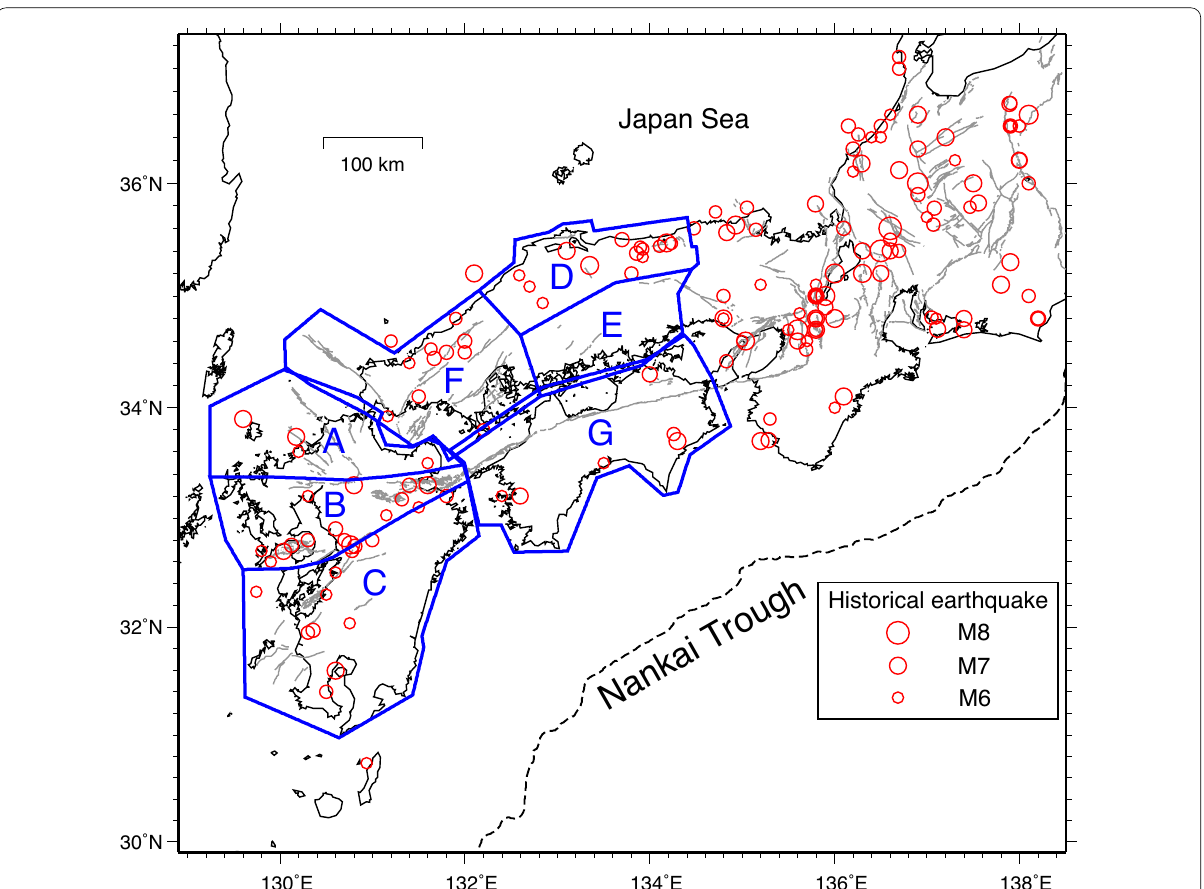
Fig. 8 Subregion used in the regional long-term evaluation of crustal earthquakes (Earthquake Research Committee 2017). Red circles indicate epicenters of M 6 crustal earthquakes from 599 to 2020 in the analyzed region ≥